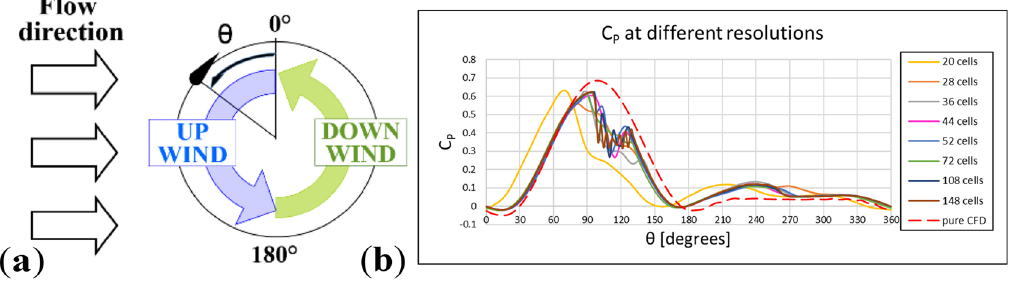
Figure 5. ( a ) Scheme of upwind and downwind path; ( b ) C P for a single blade at different resolution.